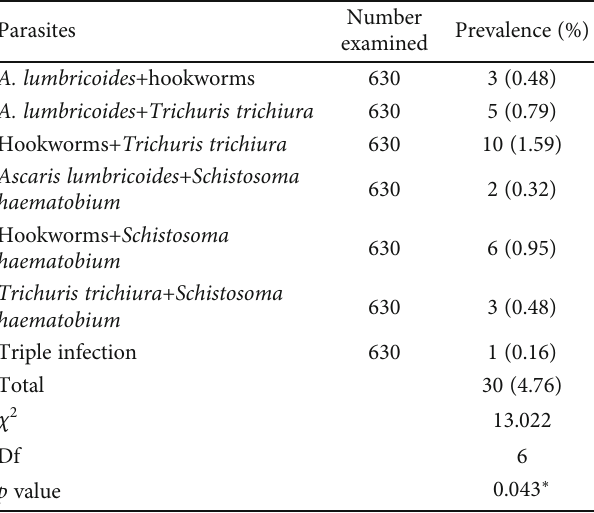
Table 4: Prevalence of coinfection of STHs and Schistosoma